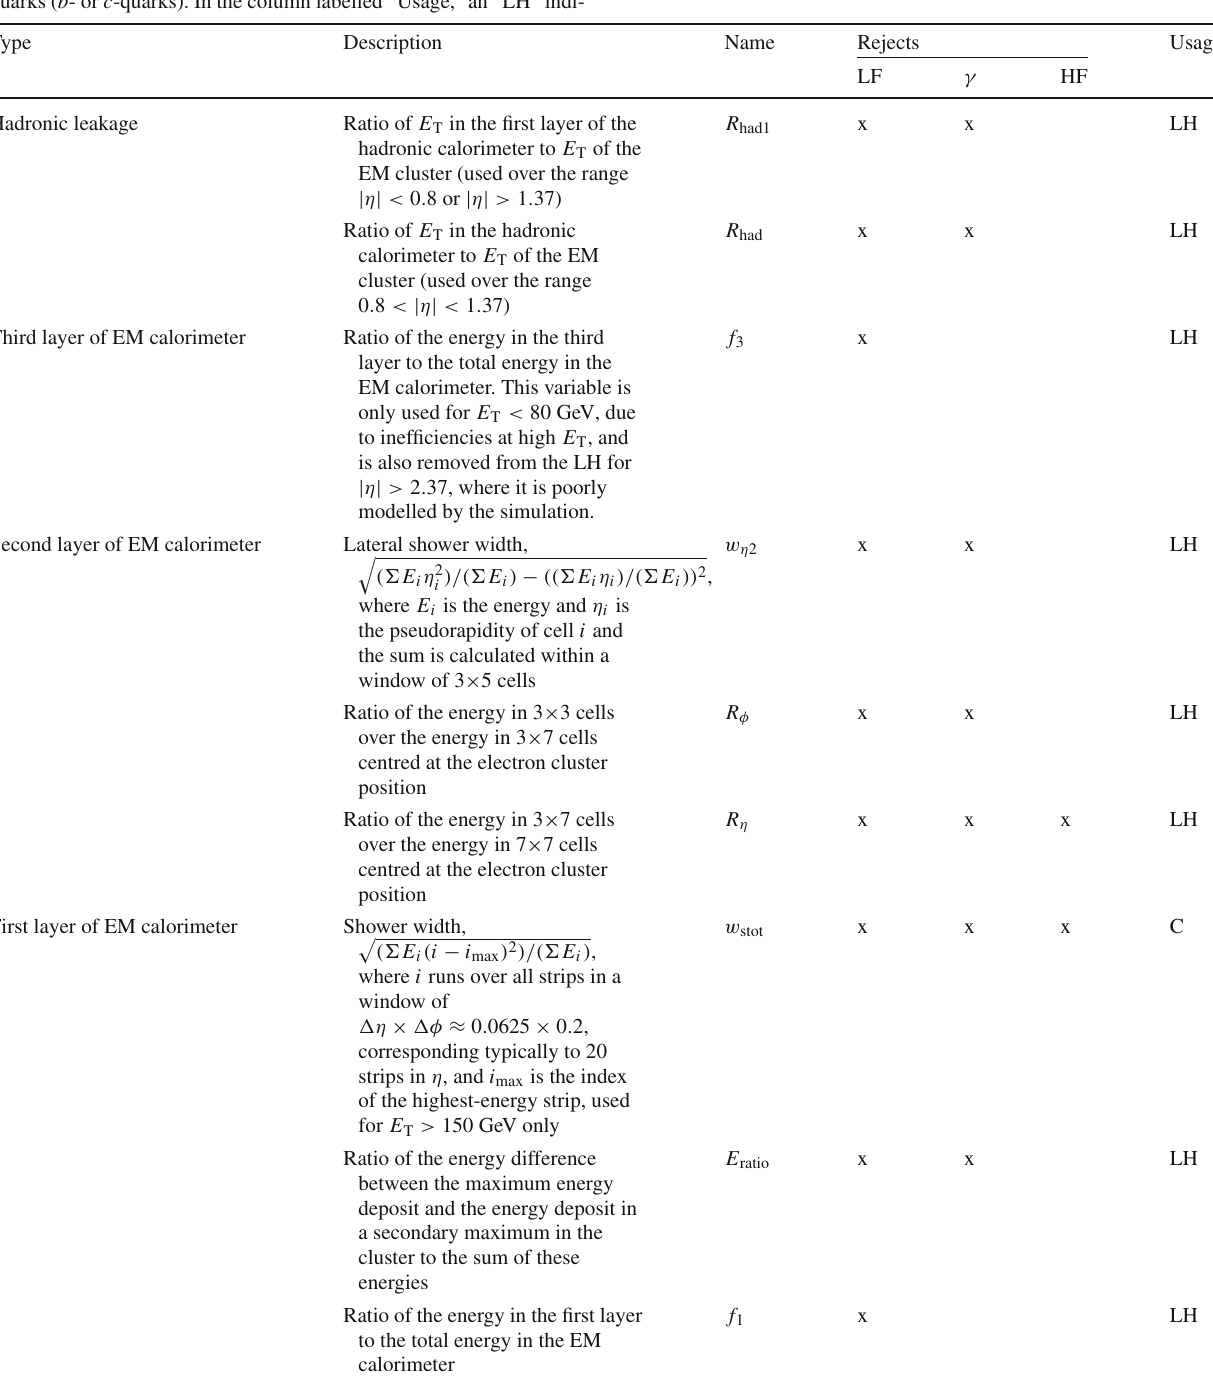
Table 1 Type and description of the quantities used in the electron identification. The columns labelled “Rejects” indicate whether a quan- tity has significant discrimination power between prompt electrons and light-flavour (LF) jets, photon conversions ( γ ), or non-prompt electrons from the semileptonic decay of hadrons containing heavy-flavour (HF) quarks ( b - or c -quarks). In the column labelled “Usage,” an “LH” indi-